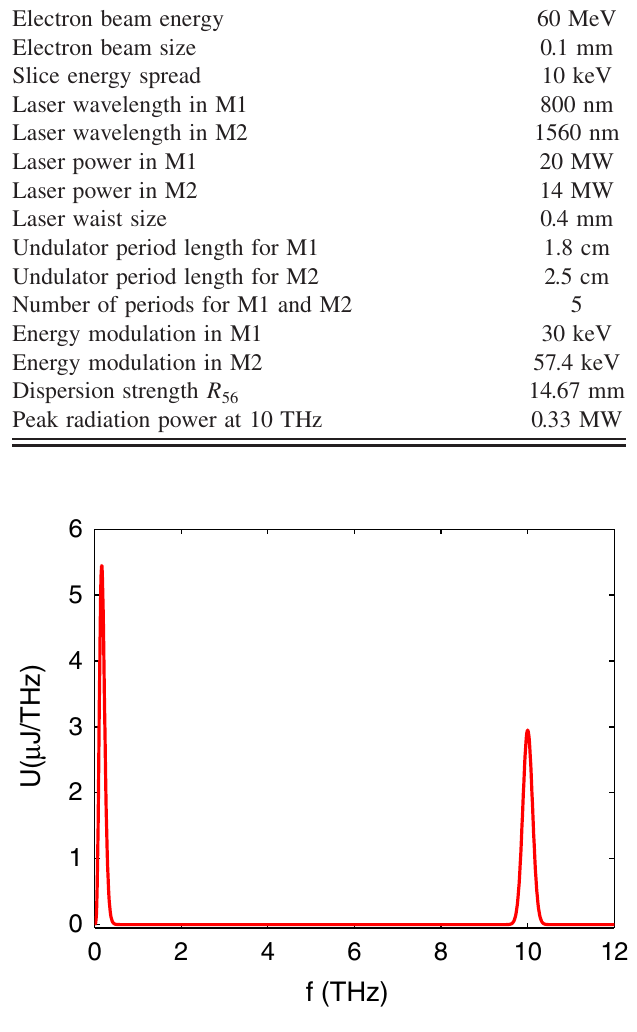
FIG. 7. (Color) Radiation energy density for a laser-modulated